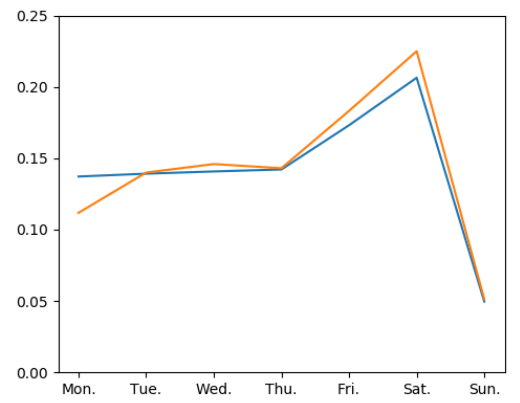
Figure 14. Aggregated occupancy ratio R agg between 2018-01-01 and 2019-12-31, estimated with the C/DiffT method, adjusted for weekly patterns and summer time, without sundays.